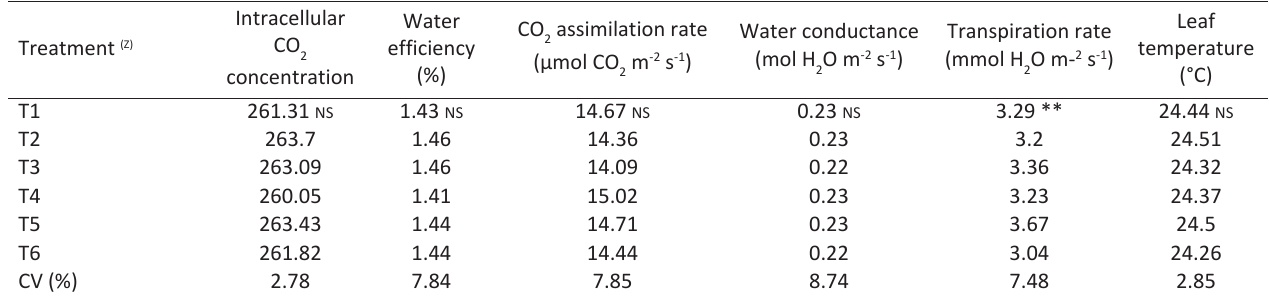
assimilation rate (μmol CO 2